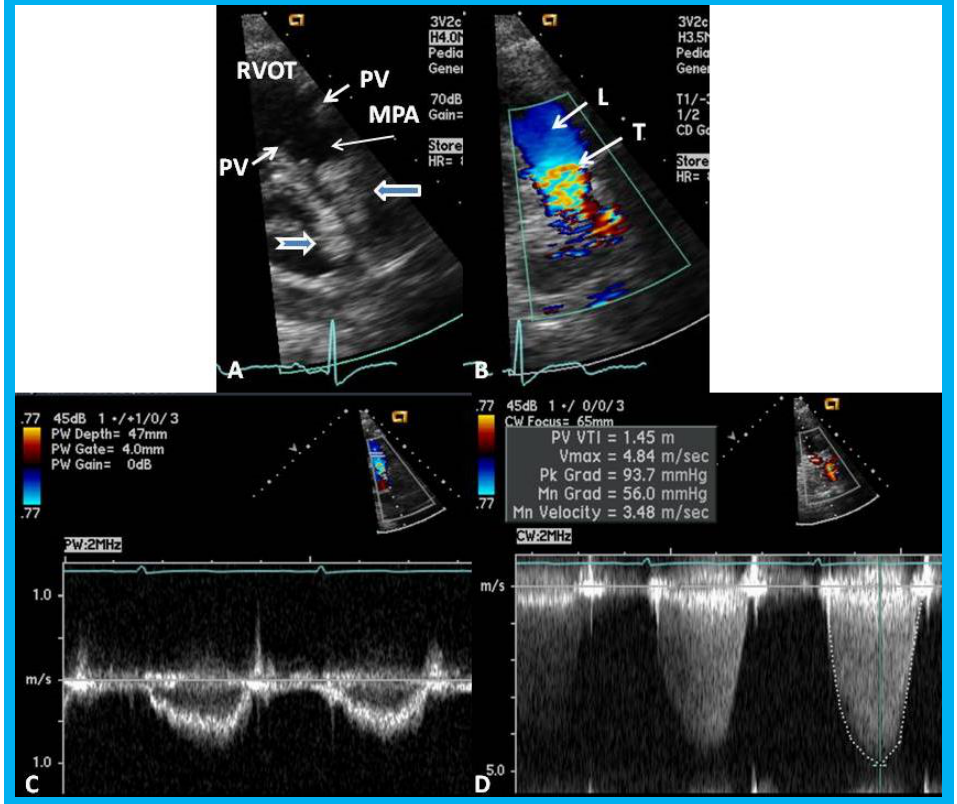
Figure 21. ( A ) Selected video frame from a parasternal short axis view showing echo dense structures (thick blue arrows) within and outside the main pulmonary artery (MPA): Pulmonary valve (PV) leaflets (small arrows) are shown and appear normal. The right ventricular outflow tract (RVOT) and proximal MPA are free of any echo-dense structures. ( B ) Color-Doppler mapping of the same structures as in panel A shows normal laminar (L) flow in the RVOT and proximal MPA and turbulent (T) flow starting in the proximal MPA, indicating obstruction. ( C ) Pulse Doppler sampling from the proximal MPA, which shows normal flow velocity. ( D ) Continuous wave Doppler sampling demonstrating high velocity flow across the MPA with a calculated peak instantaneous gradient of 93.7 mmHg and a mean gradient of 56 mmHg, indicating severe obstruction. Reproduced from Mazur L., et al.